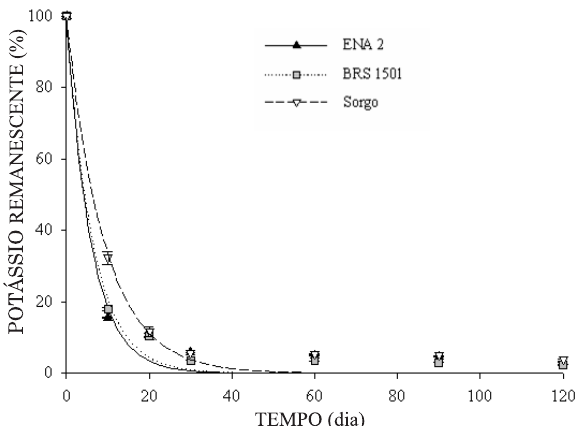
Figura 4. Teores de potássio na matéria seca remanescente das plantas de cobertura em avaliações realizadas ao longo do tempo em bolsas de decomposição na superfície do solo (A equação e a significância dos ajustes estão apresentadas no Quadro